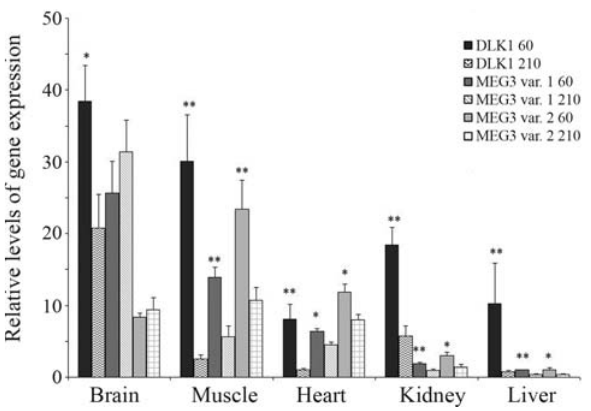
Figure 1 - DLK1 , MEG3 var.1 and MEG3 var. 2 gene expession in various porcine tissues at 60 and 210 days after birth. Values are presented as mean (cid:3) SEM. Asterisks indicate significant differences between 60 and 210 days for each gene. *p < 0.05, **p < 0.01.